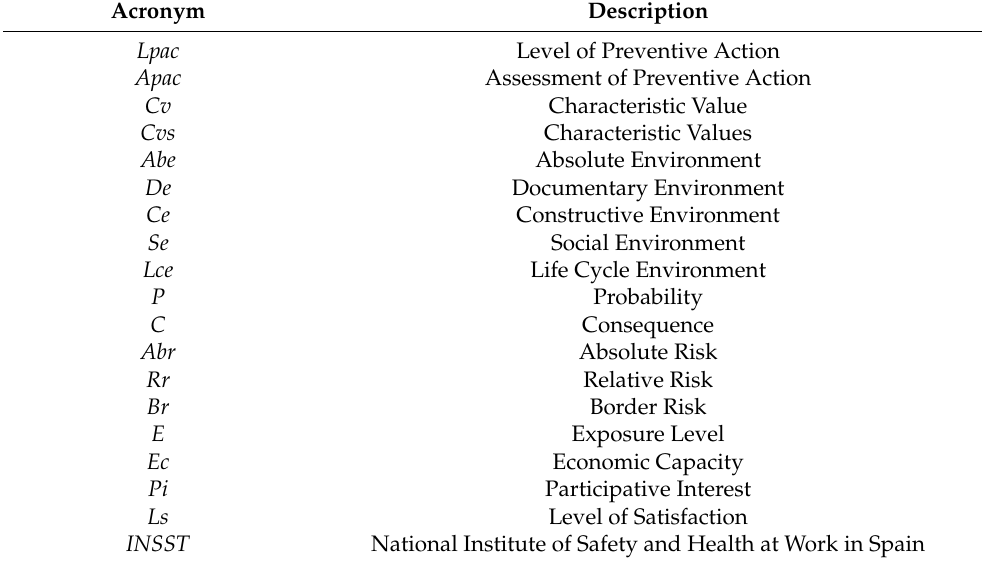
Table A1. List of acronyms used in the